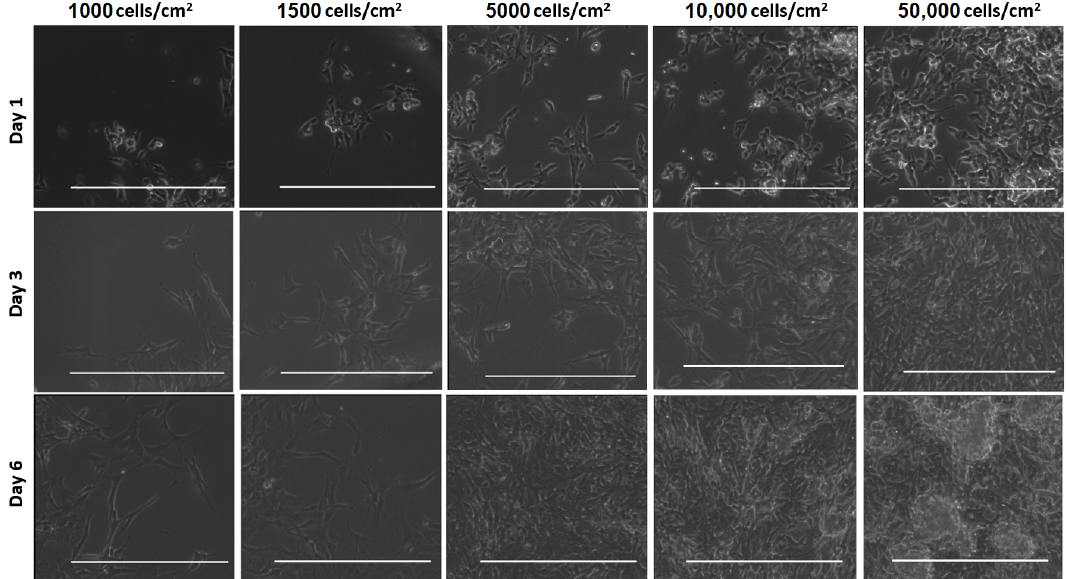
Figure 6. 3D SH-SY5Y neuroblastoma cell cultures in GelMA within a PDMS ring on glass coverslips observed on day 1, 3, and 6, starting from different initial cell densities. Representative images were taken with an EVOS FL microscope in the bright-field mode. The scale bars denote 400